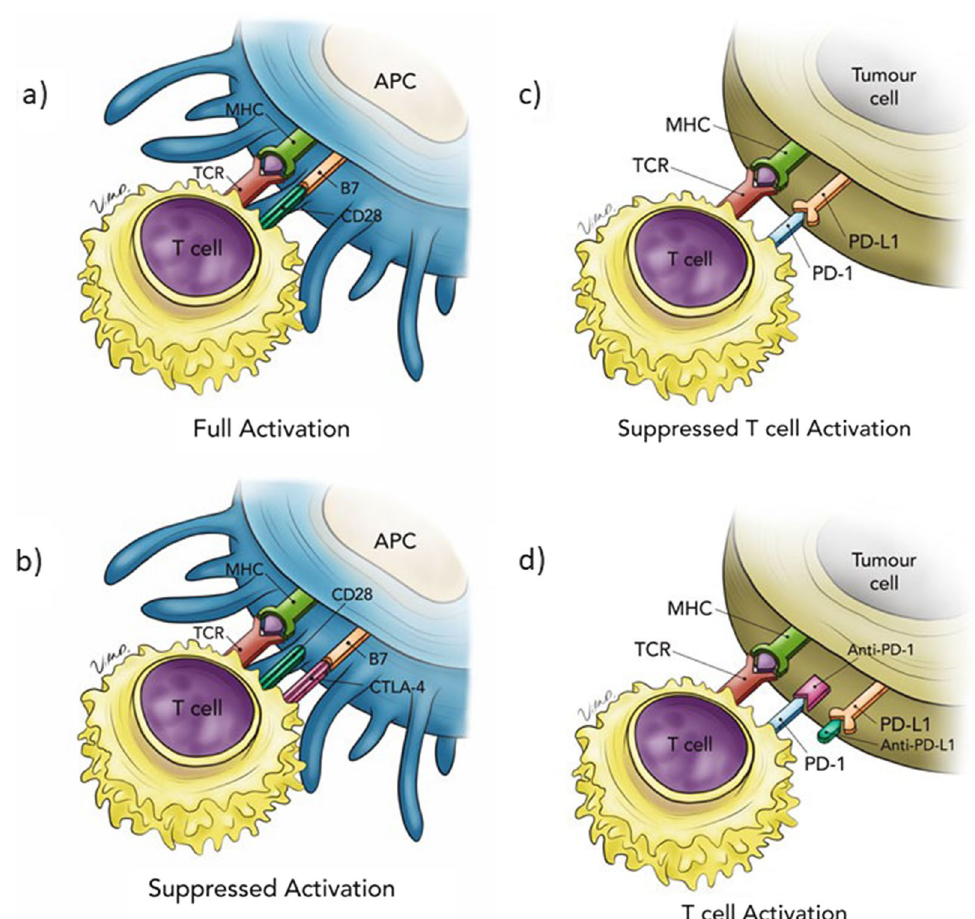
Fig. 1 Schematic of CTLA-4 activate ( a ) and blockade ( b ); steps involved in generation of tumor-specific T cells. The figure shown is a schematic of an APC, with associated cell–cell interactions via CTLA-4/B7. Tumor-associated antigens or neo-antigens are presented by MHC on APCs or tumor cells to T cells with appropriate TCR. CD28 co-activating receptor on T cells binds B7 on APCs. Schematic of PD-1/PD-L1 blockade ( c ) and activate ( d ); steps involved in generation of tumor-specific T cells. Anti-PD-1 and PD-L1antibodies are